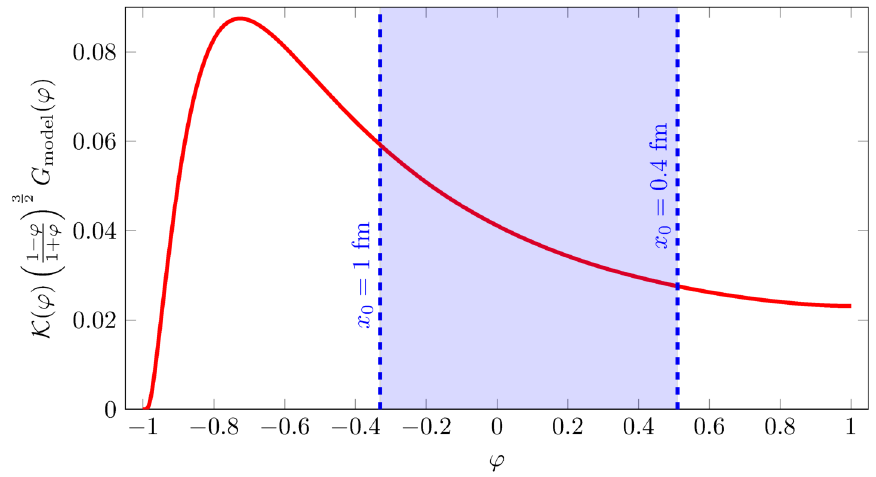
(cid:0) (cid:1) m 2 µ units as a function of ϕ in α a HVP µ π t 0 model